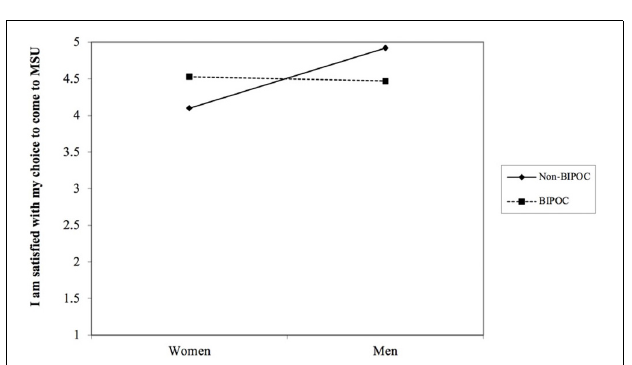
FIGURE 3 | Gender interacting with BIPOC to predict MSU environment item “I am satisfied with my choice to come to MSU.”